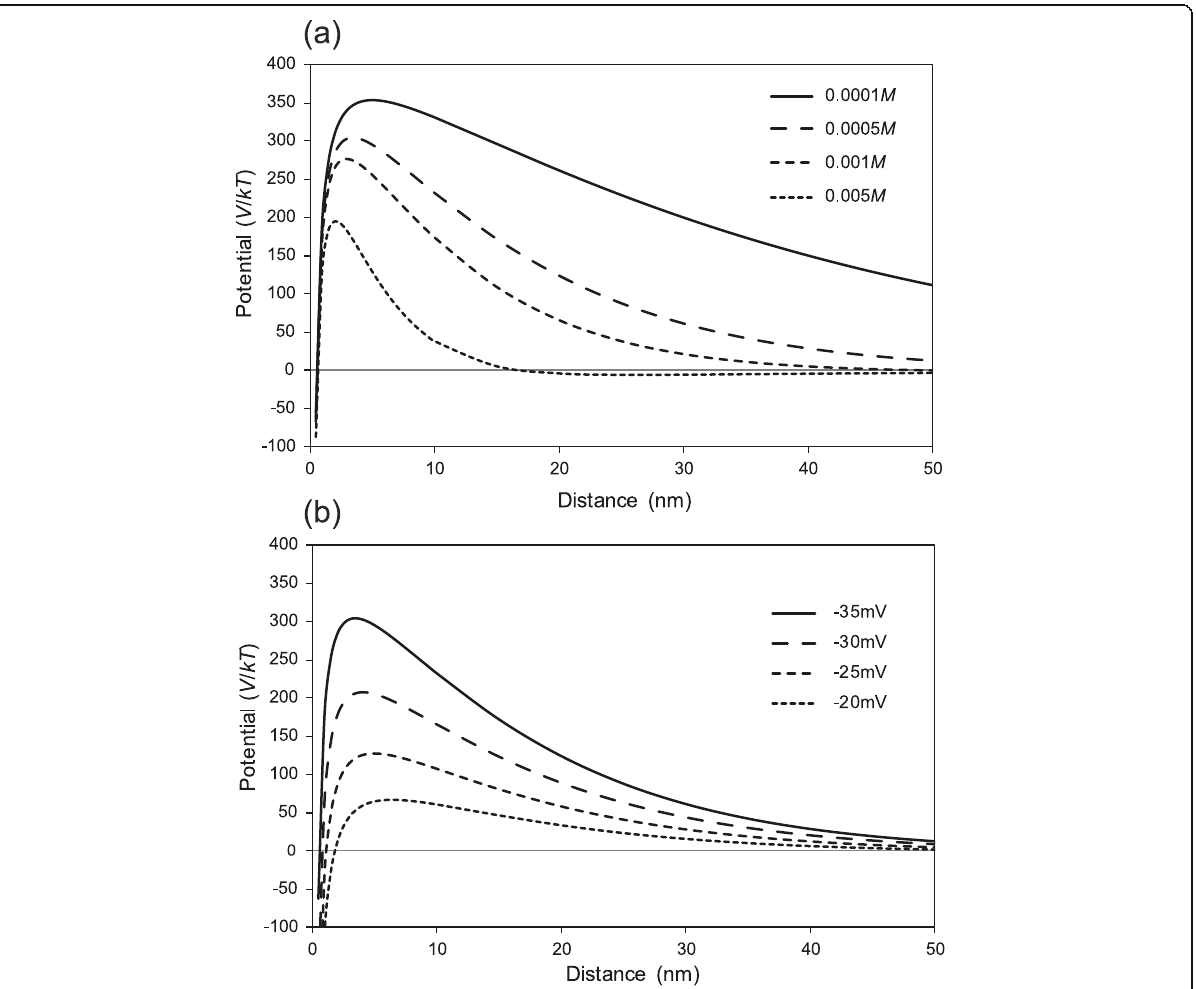
Fig. 10 Interparticle potential (in kT ) based on DLVO theory. (a) The zeta potential was set at − 35 mV. (b) The solute concentration was set as 5.0 × 10 − 4